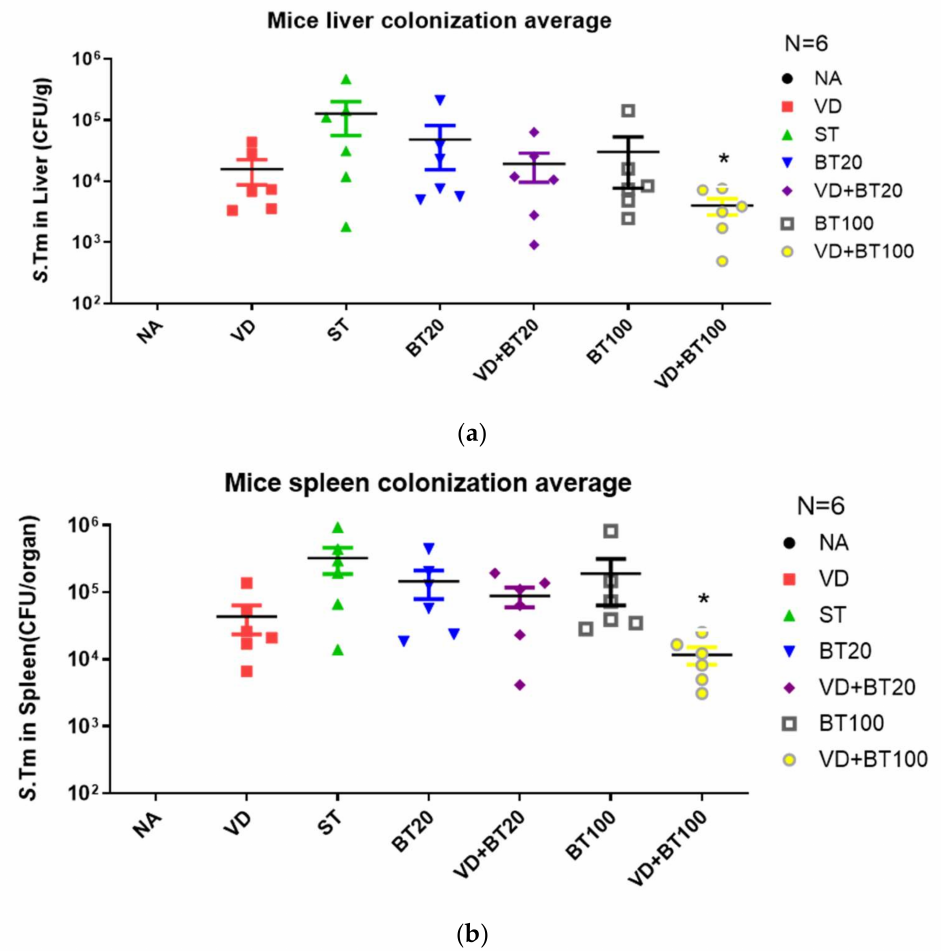
Figure 3. A combination of butyrate and 1,25D3 attenuates the systemic bacterial translocation of Salmonella colitis mice. Six to eight-week-old female C57BL/6 mice were infected with 10 8 CPU of S. typhimurium (SL1344 strain) for 48 h, untreated or treated with 1, 25 D3 and/or butyrate daily to day 14. Numbers of bacteria were counted from the liver ( a ) and spleen ( b ) homogenates of control, Salmonella -infected, and 1,25D3, butyrate or combination-treated mice post-infection. The data shown means ± the SEM of the bacterial load in the liver and spleen (n = 6). *, p <